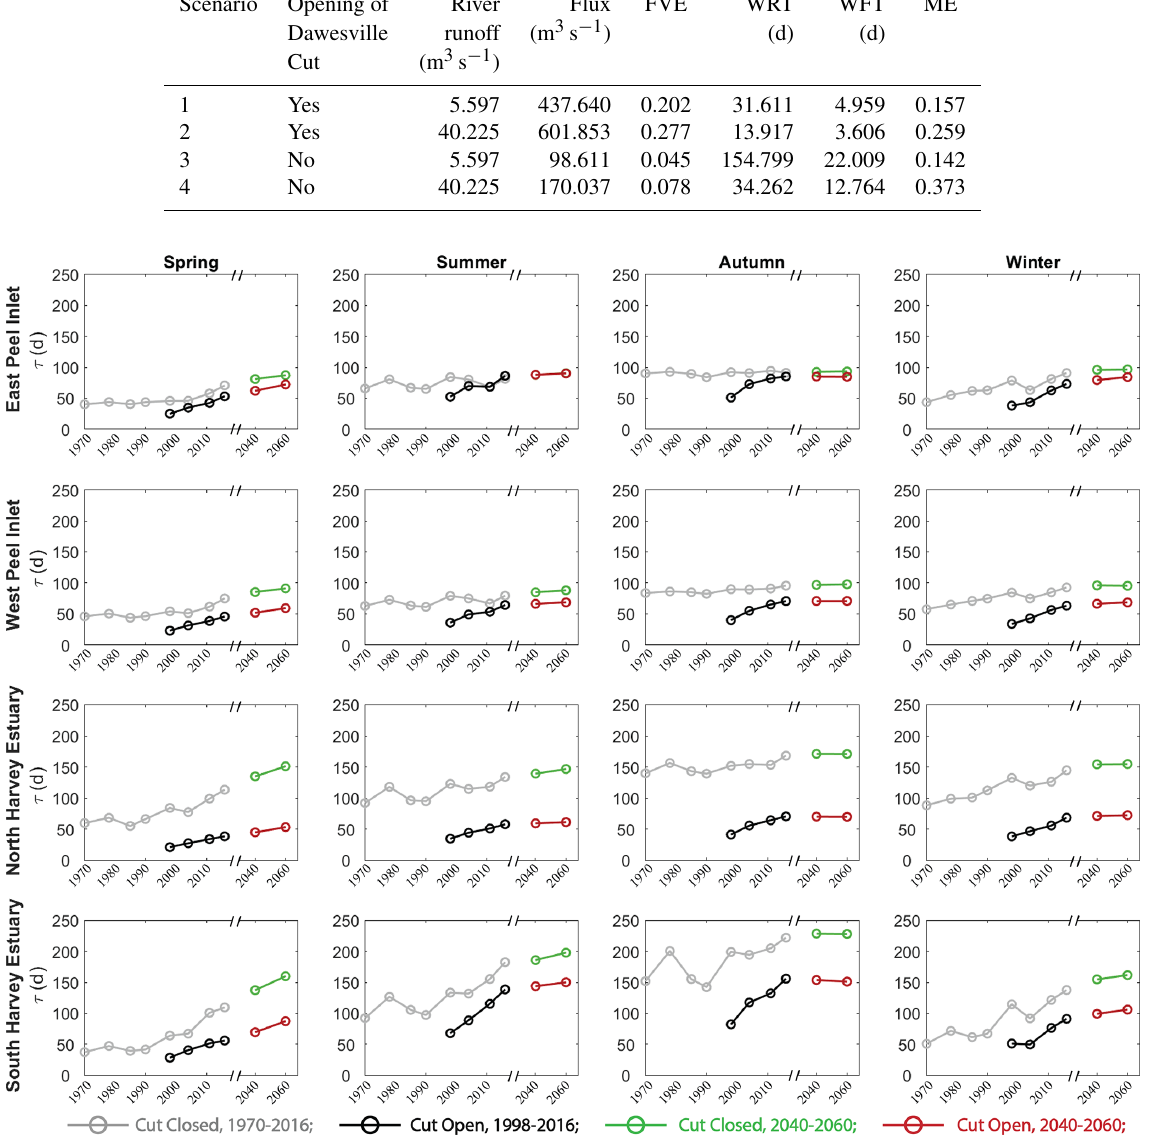
Figure 8. Mean water retention time, τ , in East Peel Inlet, West Peel Inlet, North Harvey Estuary and South Harvey Estuary (see Fig. 1 extents) in simulated years and future scenarios. The data were categorized into four seasons: spring (September–November), summer (December–February), autumn (March–May) and winter